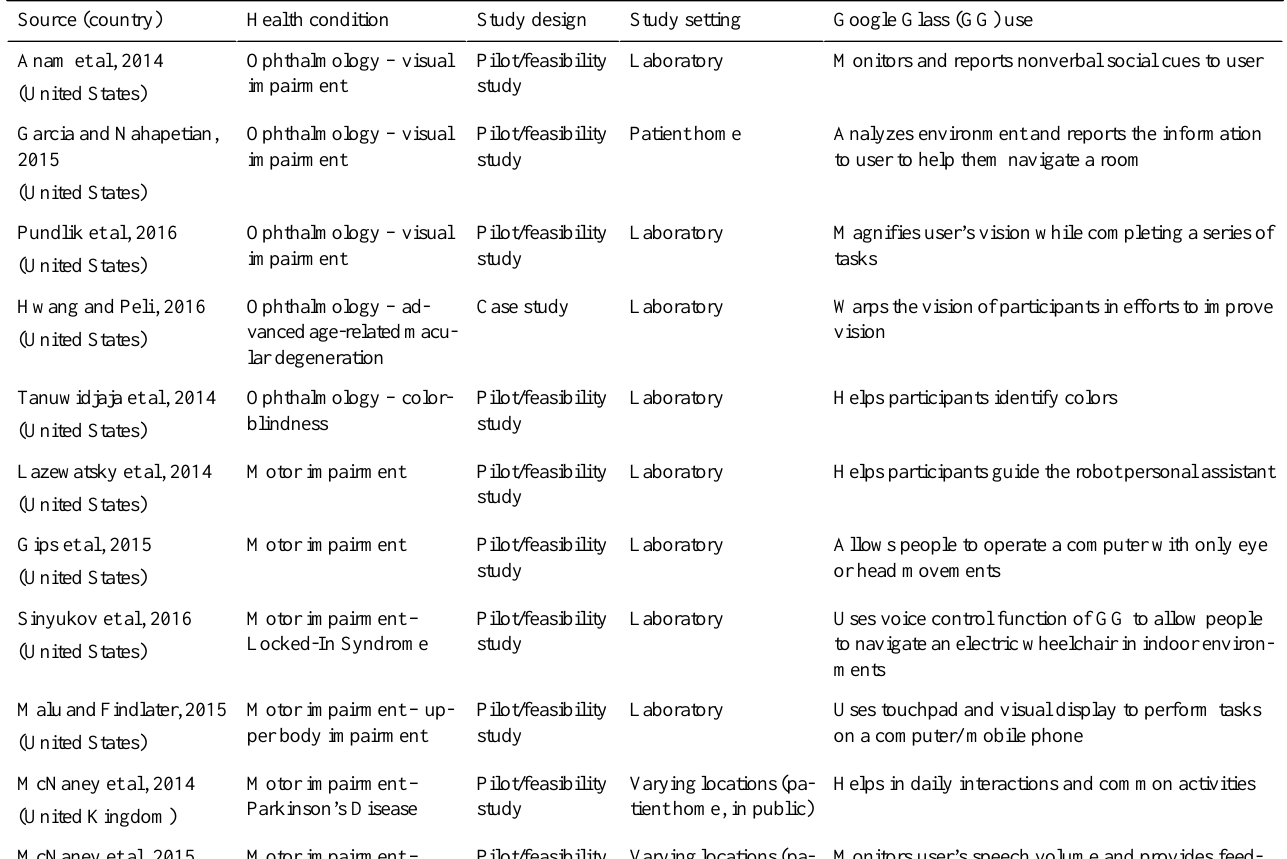
Table 1. Summary of studies using Google Glass as patient-centered